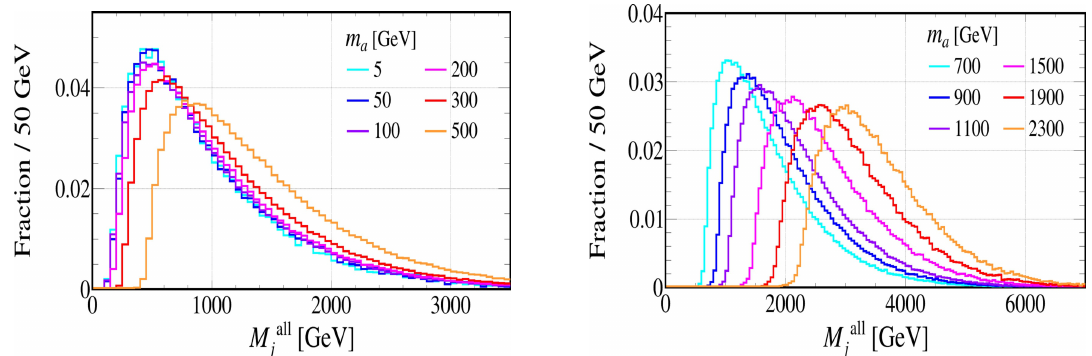
Figure 7 . Distributions of the invariant mass of all final state jets M all representative ALP masses and C ˜